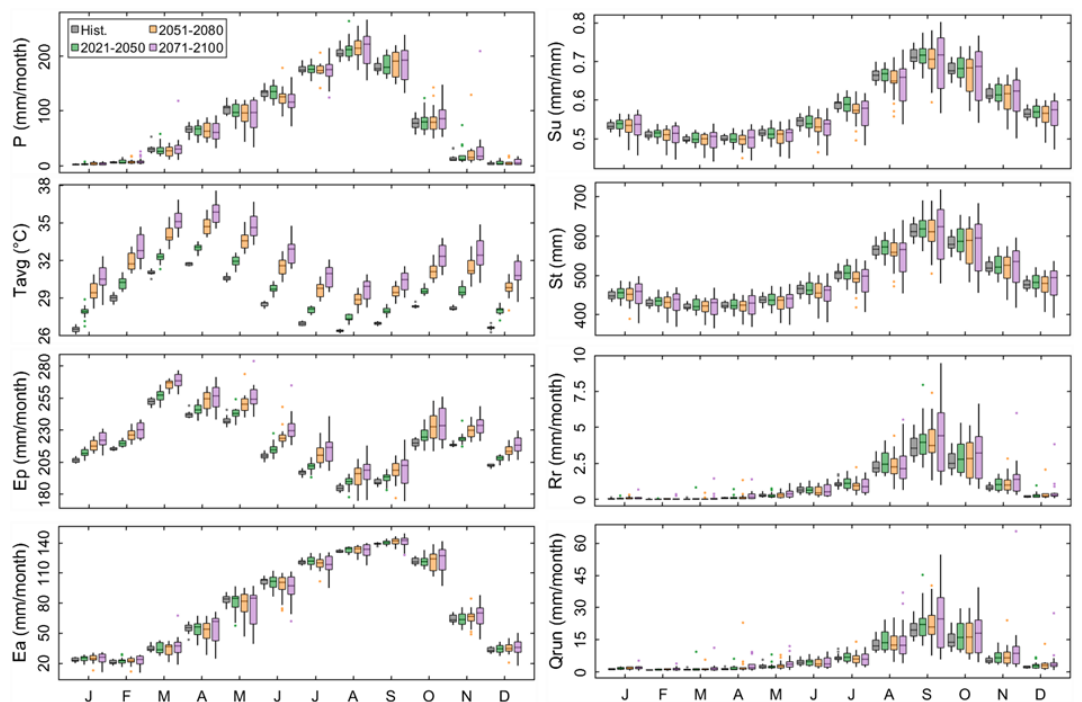
Figure 5. Annual cycles of climatic and hydrological variables over the historical and future periods (under RCP8.5). Each box plot represents the spread among the RCM–GCMs combinations (18 models). P – rainfall; T avg – average air temperature; E p – potential evaporation; E a – actual evaporation; S u – root zone soil moisture; S t – terrestrial water storage; Q run – total runoff; R r – groundwater recharge. P and T avg are RCM–GCM simulated, while the other variables come from the hydrological